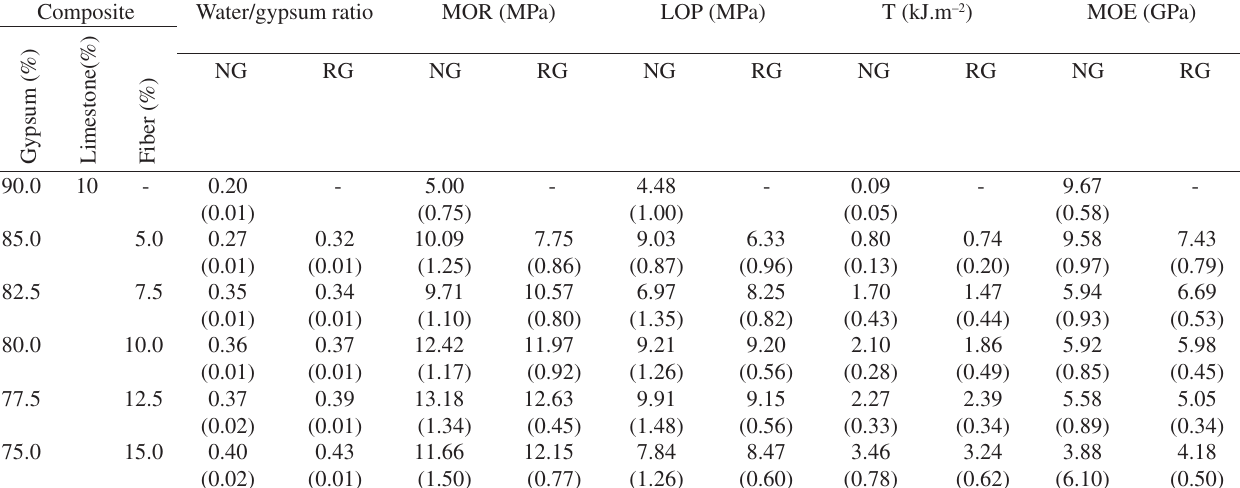
Table 4. Average values of the composites’ mechanical properties.